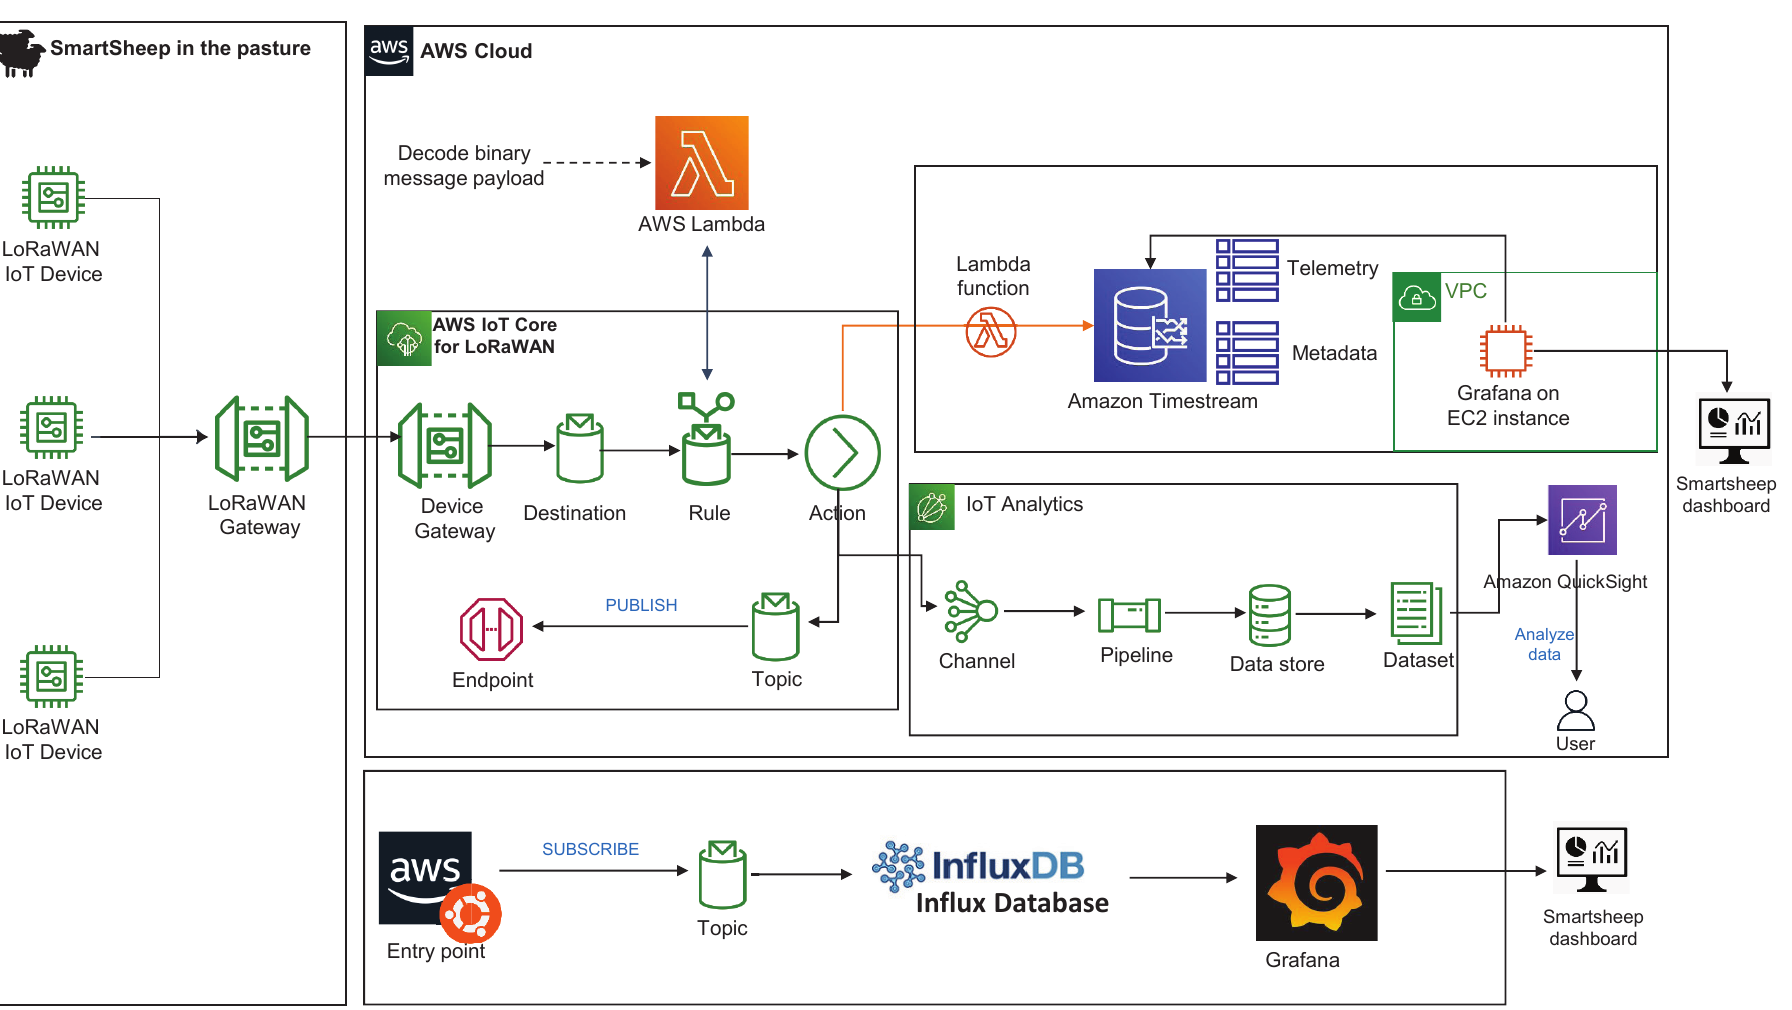
Figure 5. Smartsheep system infrastructure and communication